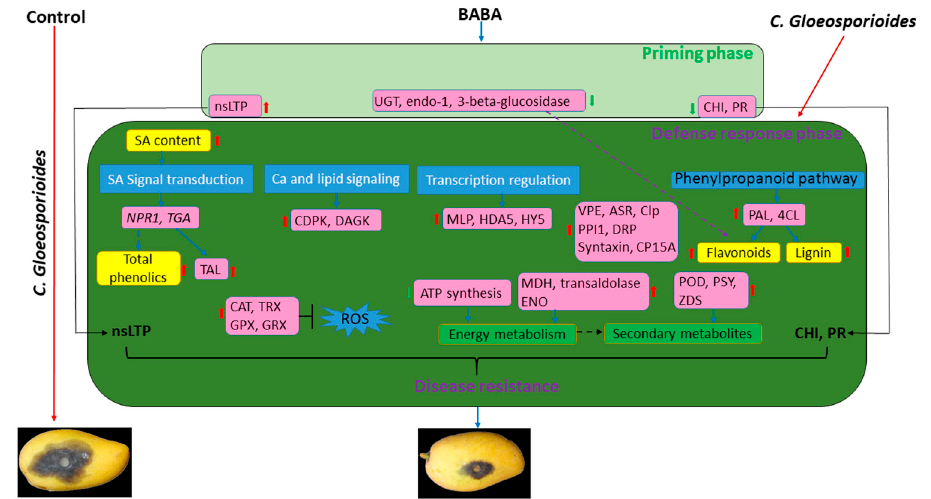
Figure 8. Presumptive model depicting the BABA priming defense mechanism. nsLTP: non-specific lipid-transfer protein; UGT: UDP-glycosyltransferase; CHI: chitinase; PR: Pathogenesis protein; NPR1: none expressor of pathogenesis-related genes; CDPK: calcium-dependent protein kinases; DAGK: diacylglycerol kinase; MLP: major latex protein; HDA5: histone deacetylase 5; VPE: vacuolar processing enzyme; CP15A: cysteine proteinase 15A; Clp: ATP-dependent Clp protease; ASR: ABA-stress-ripening; PPI1: proton pump-interactor 1; DRP: desiccation-related protein; PAL: phenylalanin ammonia-lyase; 4CL: 4-coumarate-CoA ligase; TAL: thaumatin-like protein; CAT: catalase; TRX: thioredoxin; GRX: glutaredoxin; GPX: glutathione peroxidase; MDH: malate dehydrogenase; ENO: enolase; POD: peroxidase; PSY: Phytoene synthase; ZDS: ζ -carotene desaturase. Red arrow indicates upregulation while green arrow indicates downregulation in BABA-treated mango fruit. Supplementary Materials: The following are available online at www.mdpi.com/xxx/s1, Figure S1: Venn diagrams showing the number of differentially regulated proteins in mango fruit after 4 days of storage. Figure S2: Gene expression level of SA signaling related genes, Table S1: Primer sequences of the selected genes for qRT-PCR, Table S2: Some proteins that were differentially regulated at 18 h. Table S3: Some proteins that were differentially regulated at 4 d.